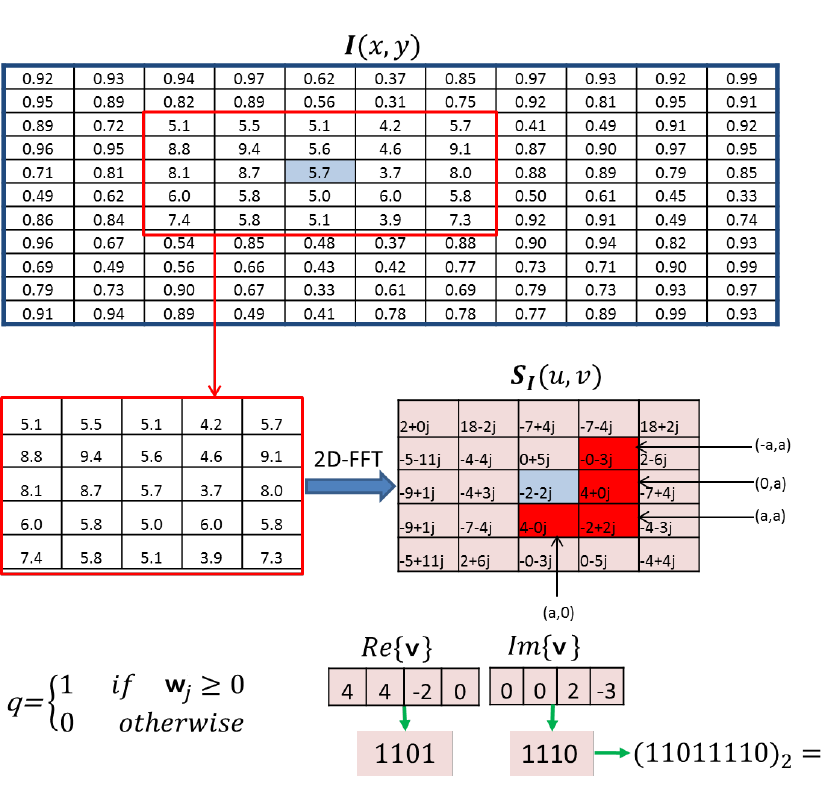
Figure 3. Local Phase Quantisation (LPQ) image encoding of a 2-D